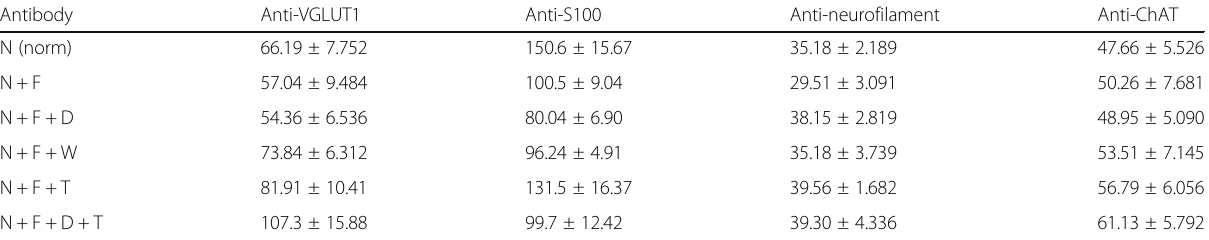
Table 3 Quantification of the immunostaining by the integrated pixel density – ratio ipsi/contralateral (%)